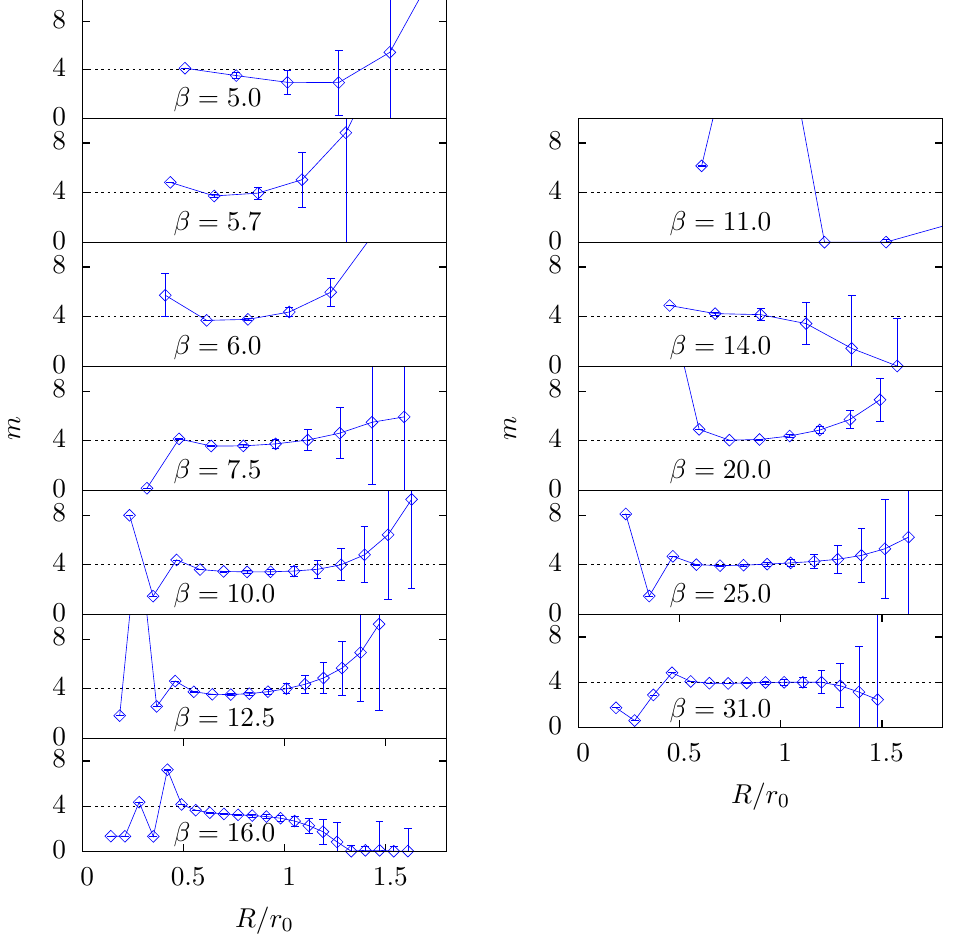
Figure 4 . Results for the exponent m plotted versus the minimal value of R included in the (cid:12)t, R min , for SU(2) (left) and SU(3) (right) gauge theory. The horizontal line indicates the LO exponent of the